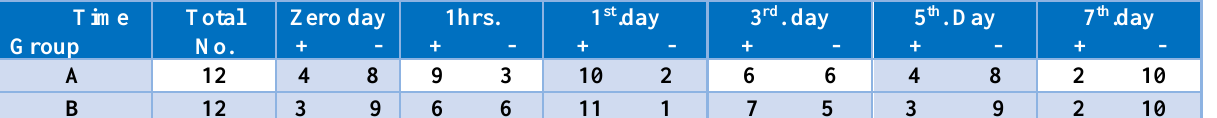
Table, 5: C - reactive protein